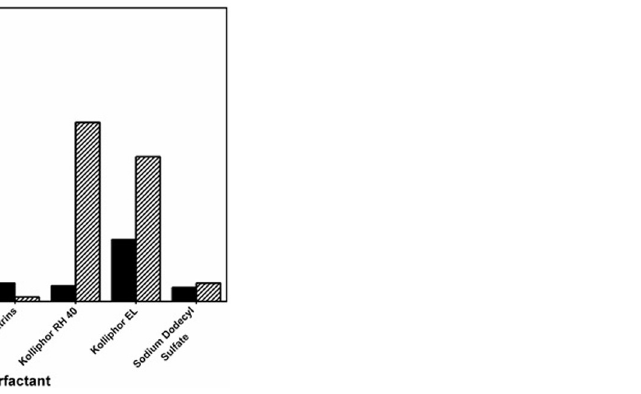
Fig 4. Effect of type of surfactant (1mL 1% w/v solution of each) on the RFI values of their interaction mixture with LAP (1000 ng/mL). Solid black bars: kolliphor RH 40, stripped bars: mixture of LAP and kolliphor RH 40.